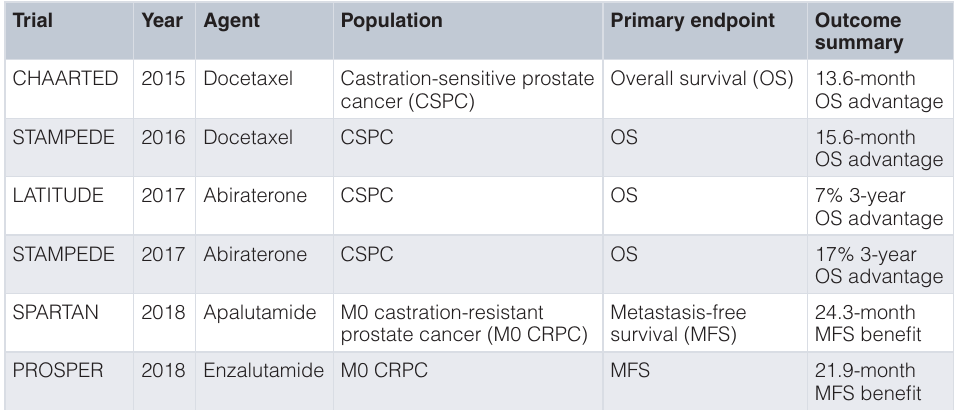
Table 1. Summary of recent trials in castration-sensitive prostate cancer and non-metastatic (M0) castration-resistant prostate